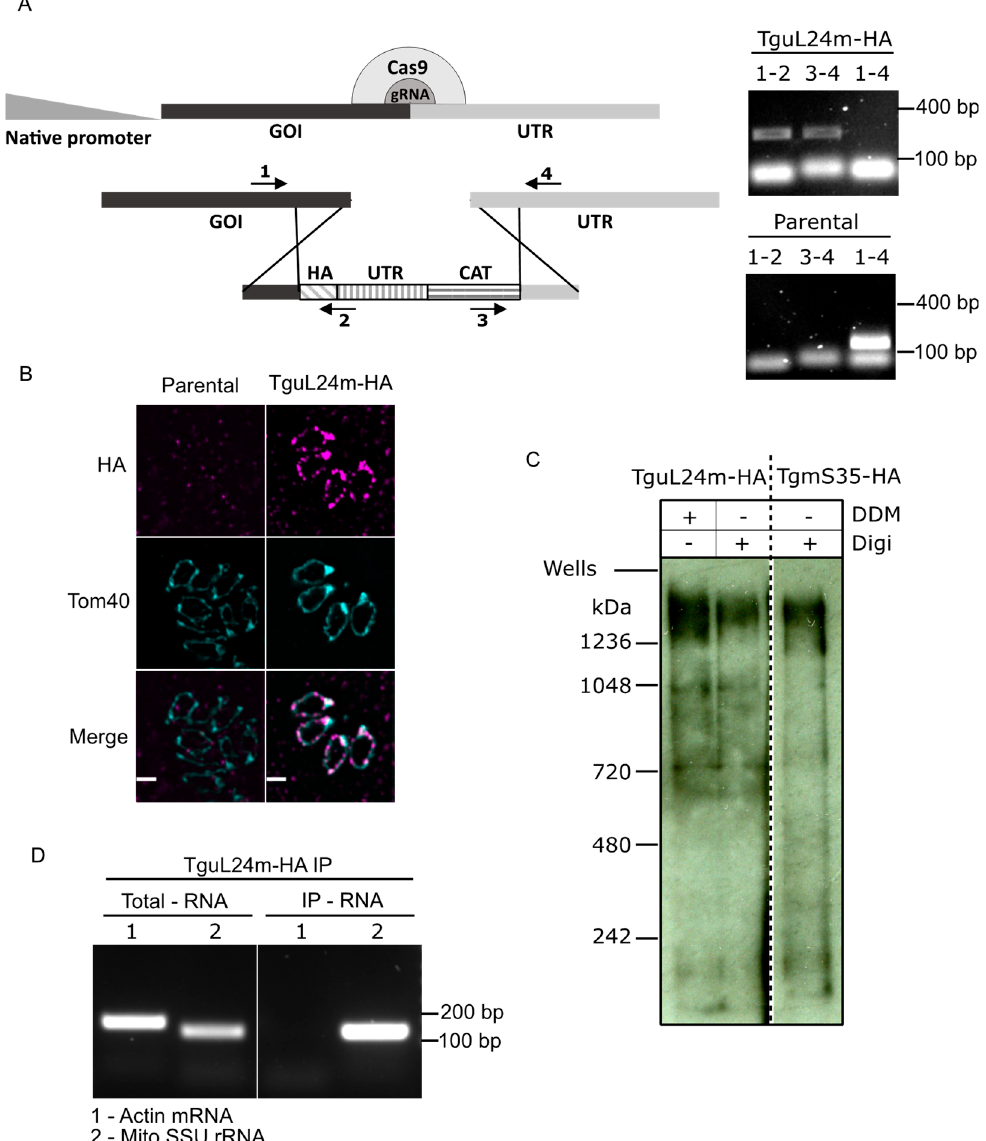
Figure 1. Evidence supporting the affiliation of a Toxoplasma uL24m homolog as a mitoribosomal component. ( A ) (Left) Scheme describing the genetic manipulation for endogenous HA tagging of Tg uL24m . (Right) Validation of the tag integration in the Tg uL24m locus via PCR analysis using primers 1, 2, 3, and 4, shown in the scheme on the left. ( B ) Immunofluorescence micrographs taken with the RH ∆ ku80/TATi parental cell line and TguL24m-HA tagged cell line, probed with anti-HA and anti-Tom40 antibody showing expression of the HA tag only in the tagged line and colocalization with the mitochondrial marker Tom40. Scale bar = 1 µ m ( C ) Total cells from TguL24m-HA and TgmS35-HA cell lines treated with detergents Digitonin (Digi) and N-Dodecyl b-D-maltoside (DDM) as depicted, followed by separation on Blue-Native PAGE and immunoblotted to visualize HA tagged TguL24m and TgmS35 by probing with anti-HA antibody showing migration of TguL24m and TgmS35 at similar sizes regardless of detergent treatment. ( D ) RT-PCR experiment to detect mitochondrial small subunit rRNA (Mito SSU rRNA) performed on RNA sample extracted from total cells and eluate by immunoprecipitated TguL24m-HA using HA beads. RT-PCR for a cytosolic mRNA (Actin mRNA) was also performed on the same sample as negative control. The fact that TguL24m has a mitochondrial localization, high-molecular band migration and interaction with mitochondrial rRNA provide evidence for its affiliation with the